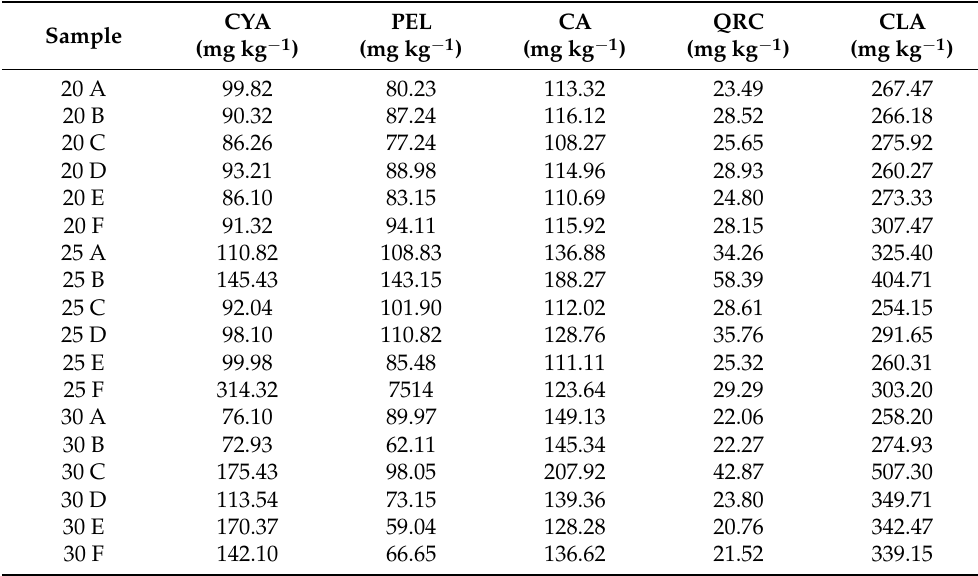
Figure 3. ( A ): HPLC chromatographic profile of sample 25 F, which showed more concentration of CYA. ( B ) HPLC chromatographic profile of sample 25 B, which showed more concentration of PEL and QRC. ( C ) HPLC chromatographic profile of sample 30 C, which showed more concentration of CLA and CA. Table 1. Phenolic compounds concentrations (mg kg − 1 ) found in the samples of blue corn flour and C. gloeosporioides fermentation.